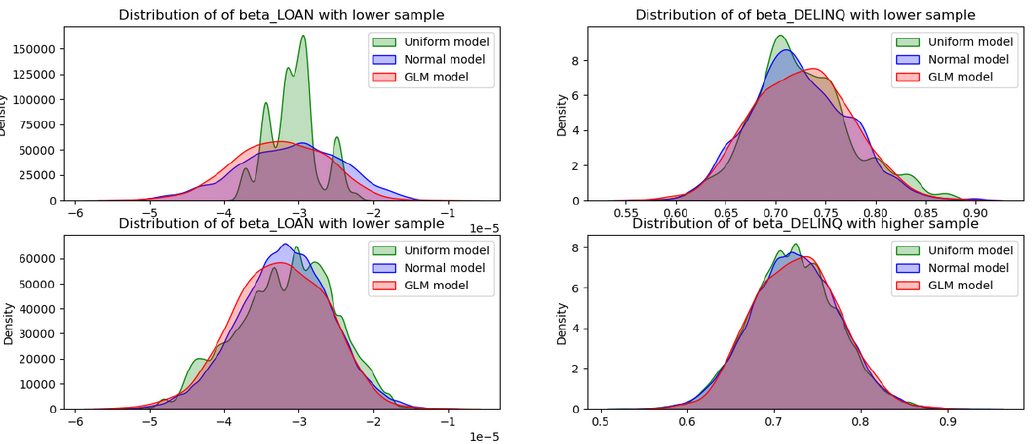
Figure 13. Distributions of variables–Comparisons between the lower (2500 samples) and higher (90,000 samples) samples.